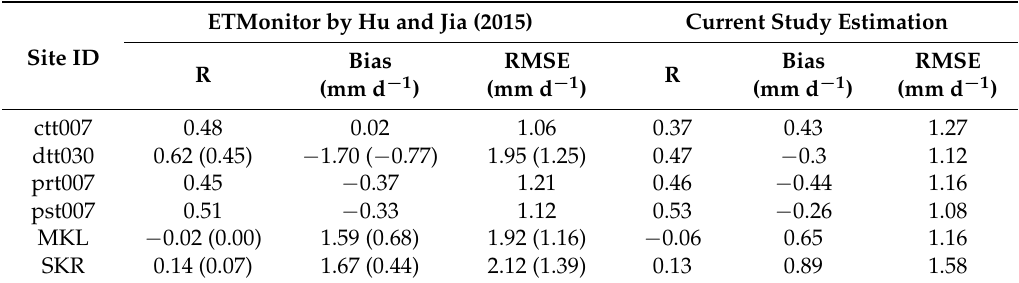
Table 3. Comparison of estimated daily ET by current improved ETMonitor and original ETMonitor by Hu and Jia (2015) with ground observed ET. Values in the baskets represent the results after adapting the parameters by Hu and Jia (2015) to the humid climate in Northeast Thailand.